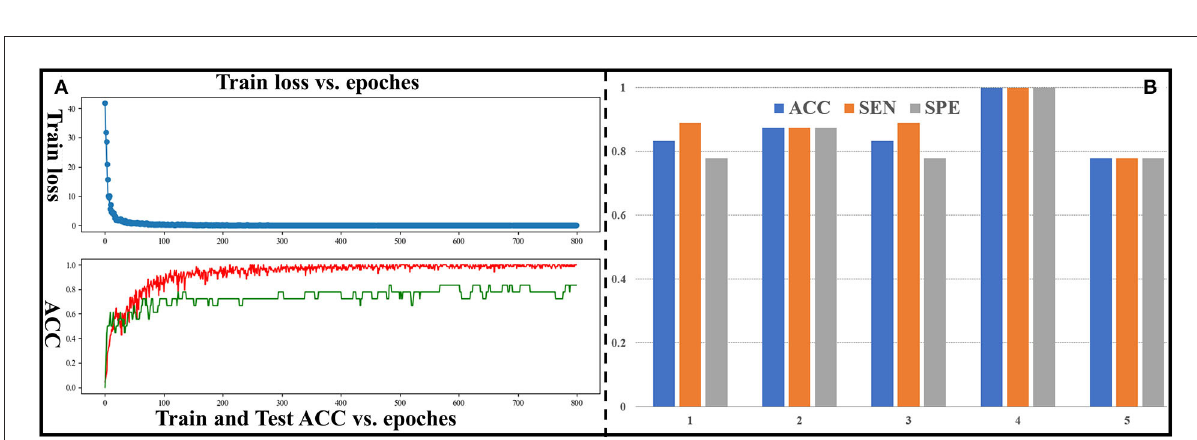
candidates (Zhu et al., 2013). In this way, the corresponding DICCCOL landmark i can be obtained across all the